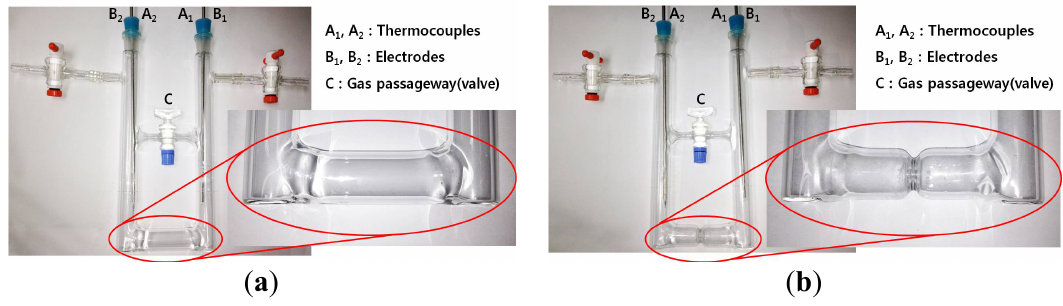
Figure 1. “U” shaped Pyrex cells: ( a ) no-waisted cell and ( b ) waisted cell.